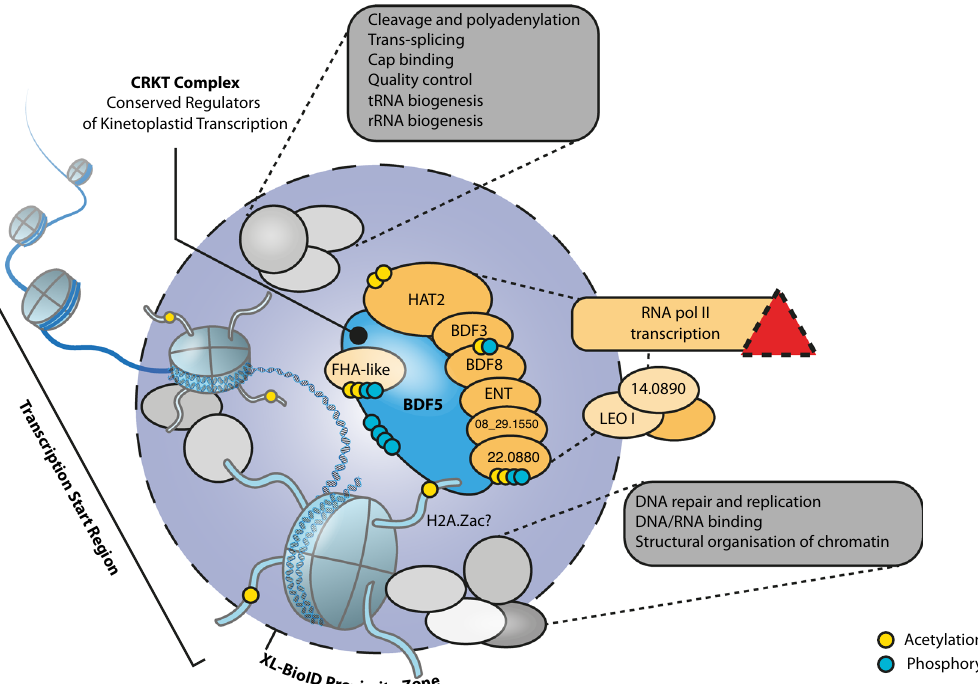
Fig. 7 A proposed model of the BDF5-de fi ned chromatin landscape and the CRKT complex. BDF5 localised to chromatin with the CRKT complex members depicted as interacting directly and in fl uencing transcription, either directly or through a putative PAF1-like complex. The red triangle indicates a disruption of transcription once BDF5 is deleted. Other proximal processes are indicated in grey boxes. Indications of detected acetylation and phosphorylation are depicted as yellow or blue dots respectively. Juxtaposition and stoichiometry of complex members are for illustration only, not to